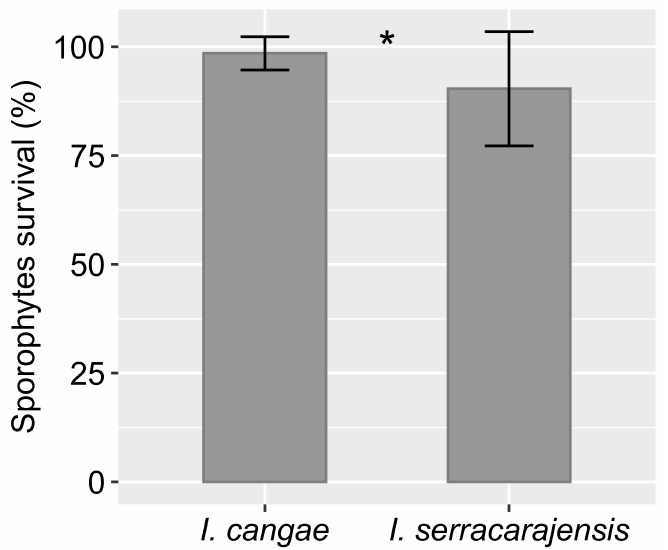
Figure 7. The sporophyte survival of Isoëtes cangae and Isoëtes serracajensis . The error bar represents the standard deviation, and * indicates significant differences by Mann–Whitney U test at p <